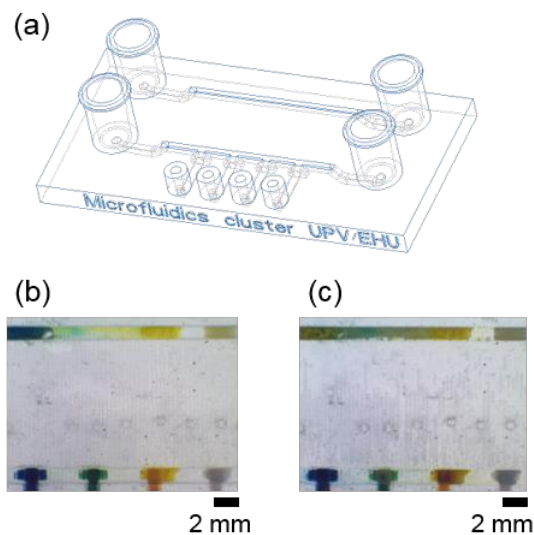
Figure 3. Adhesion tests performed to analyse the importance of the proposed architecture on the robustness of the integrated pH sensors. ( a ) 3D model representation of the microfluidic device, in which two different 3D printed structures were compared: a simple channel (top channel) and the proposed T-shaped well architecture (bottom channel). Images show the integration of the materials ( b ) right after polymerisation and rinsing with distilled water and ( c ) after 2 min flow at 600 μL min −1 , pH = 6.